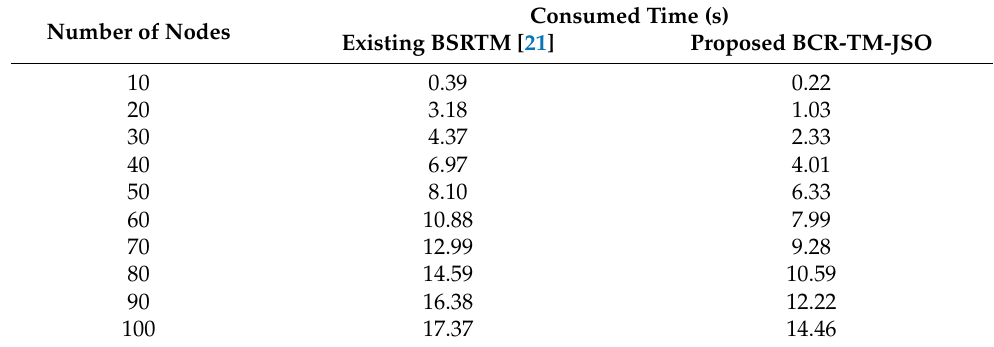
Table 7. Performances of consumed time.